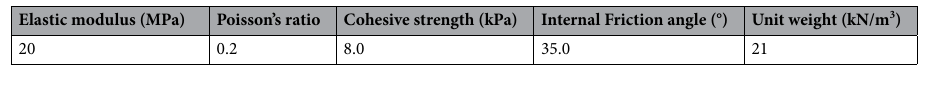
Table 1. The parameters of gully bed soil.